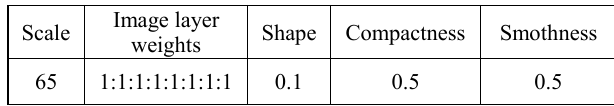
Figure 2. The process of classification and change analysis